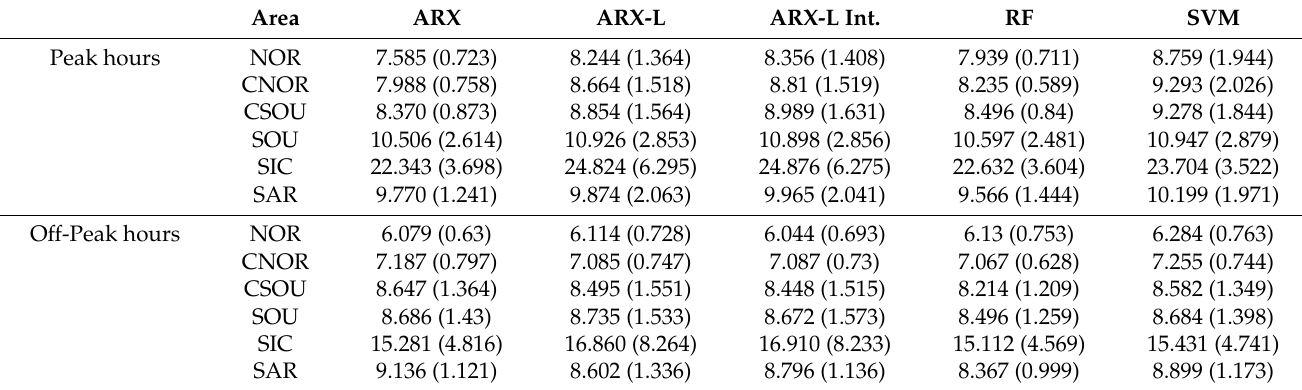
Table A5. Mean value of RMSE over peak (14 h) and off-peak (10 h) hours. In parenthesis the standard deviation. The lags of the dependent variable have been omitted.